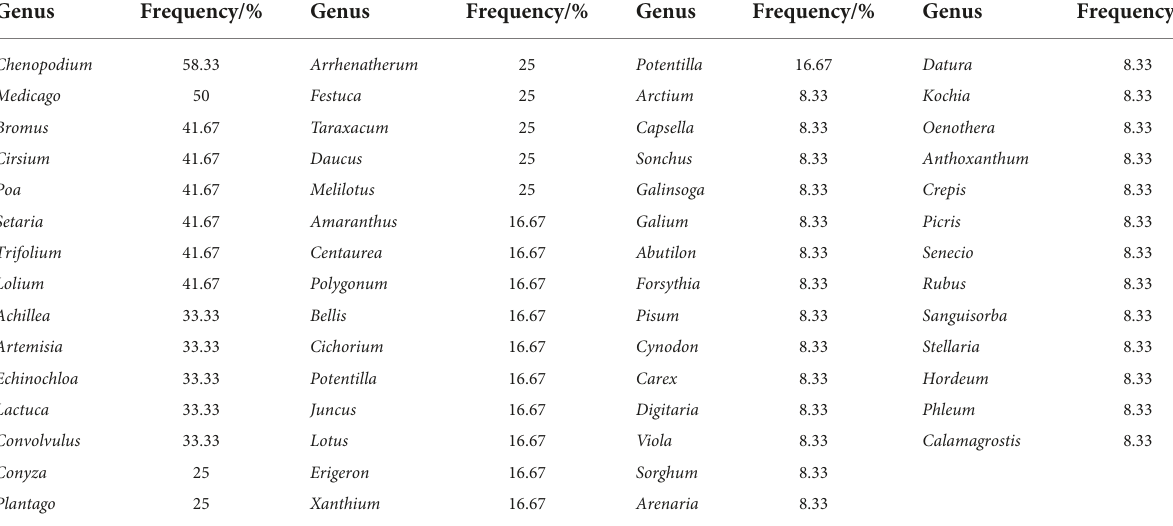
TABLE 5 Statistics of native species of Ambrosia artemisiifolia in the world